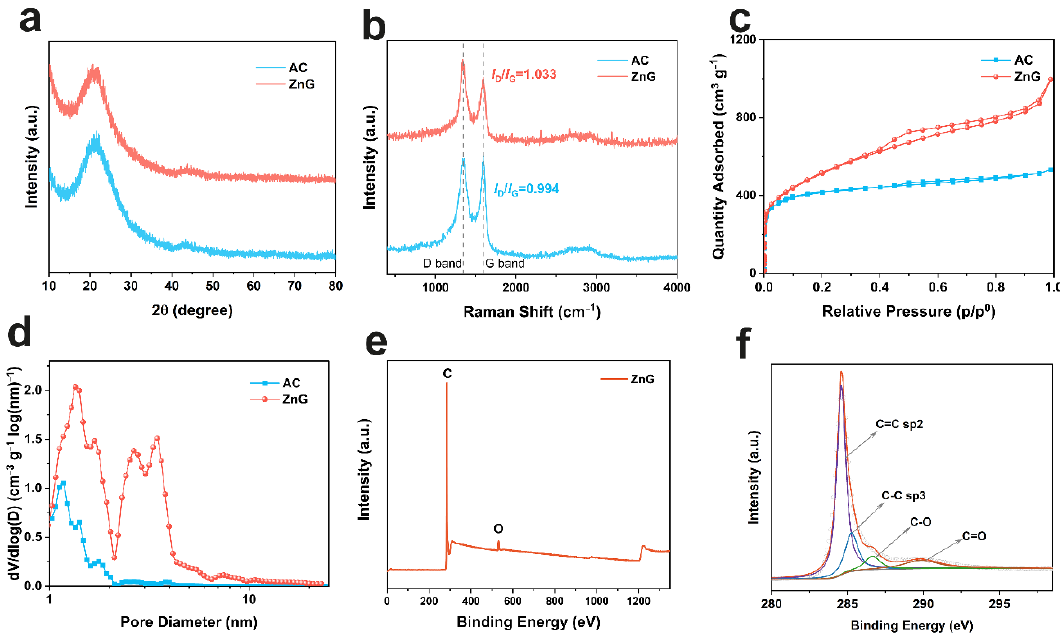
Figure 2. Spectroscopic characterization of ZnG and AC. XRD patterns ( a ); Raman spectra ( b ); nitrogen adsorption–desorption isotherms ( c ); corresponding pore size distributions ( d ); XPS survey spectrum ( e ); and high-resolution XPS spectrum of C 1s ( f ).